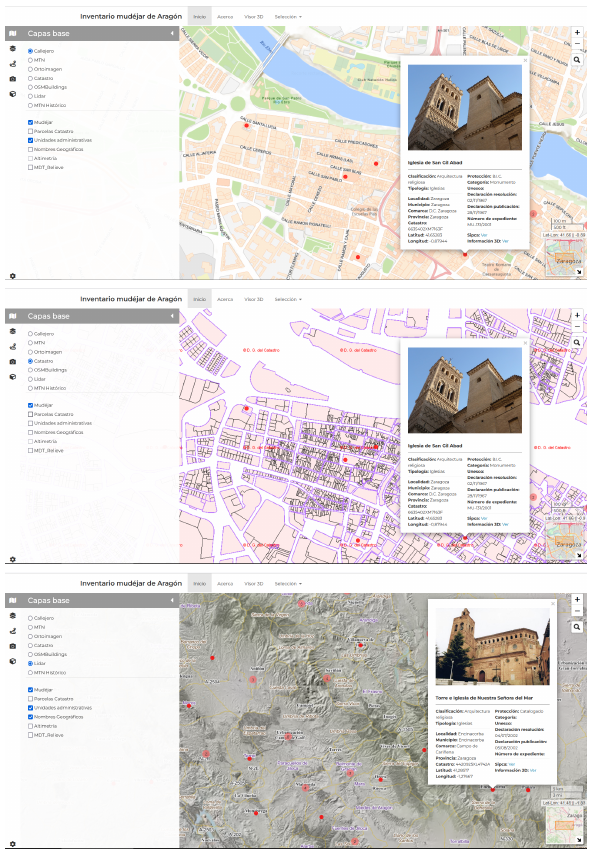
Figure 7. WebGIS viewer including (top) the street base map, (center) the cadastral plane and (bottom) the LIDAR layer, together with the lateral main menu and the pop-up building descriptive information.